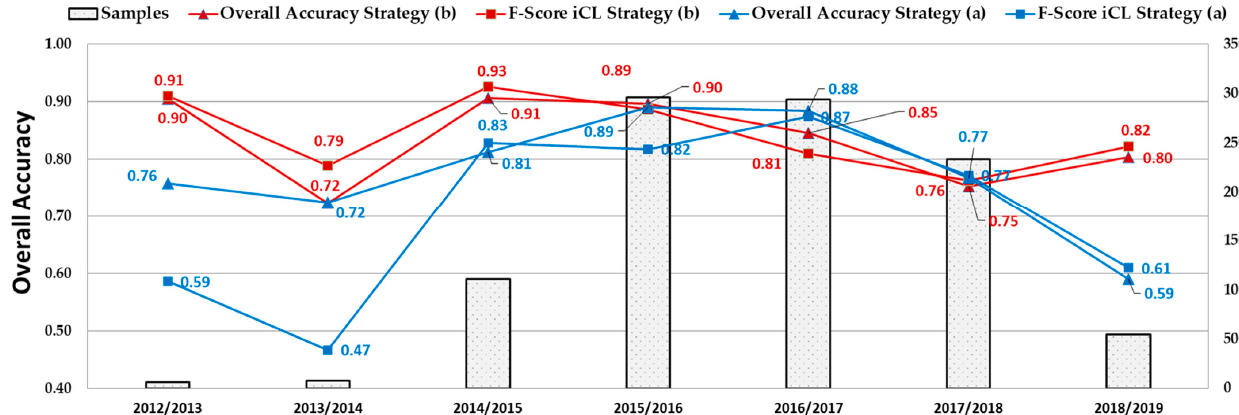
sampling strategies is shown in the top part; the number of samples (given in pixels) available per